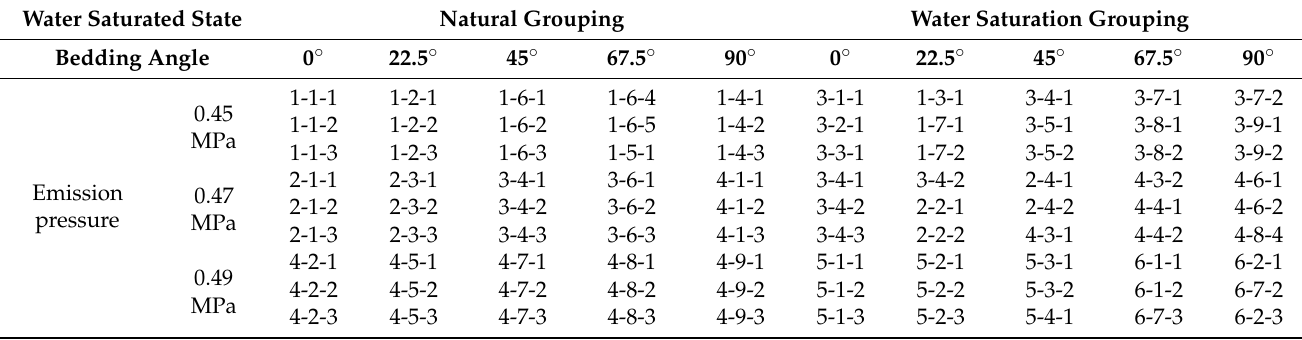
Table 1. Grouping of coal